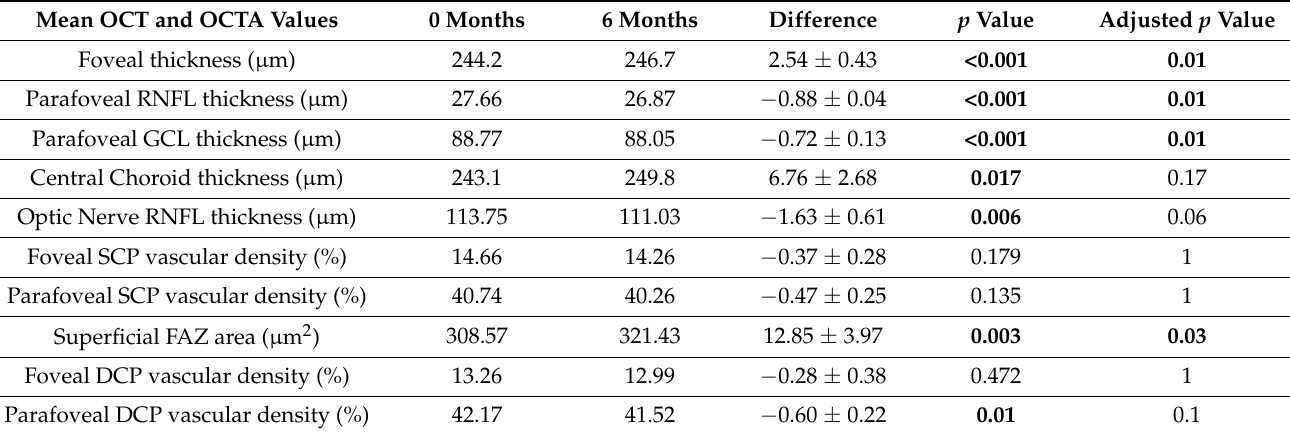
Table 2. Results from the 0–6 months prospective cohort study. Comparison of structural optical coherence tomography (OCT) and OCT angiography (OCTA) parameters in COVID-19 patients at 0 and 6